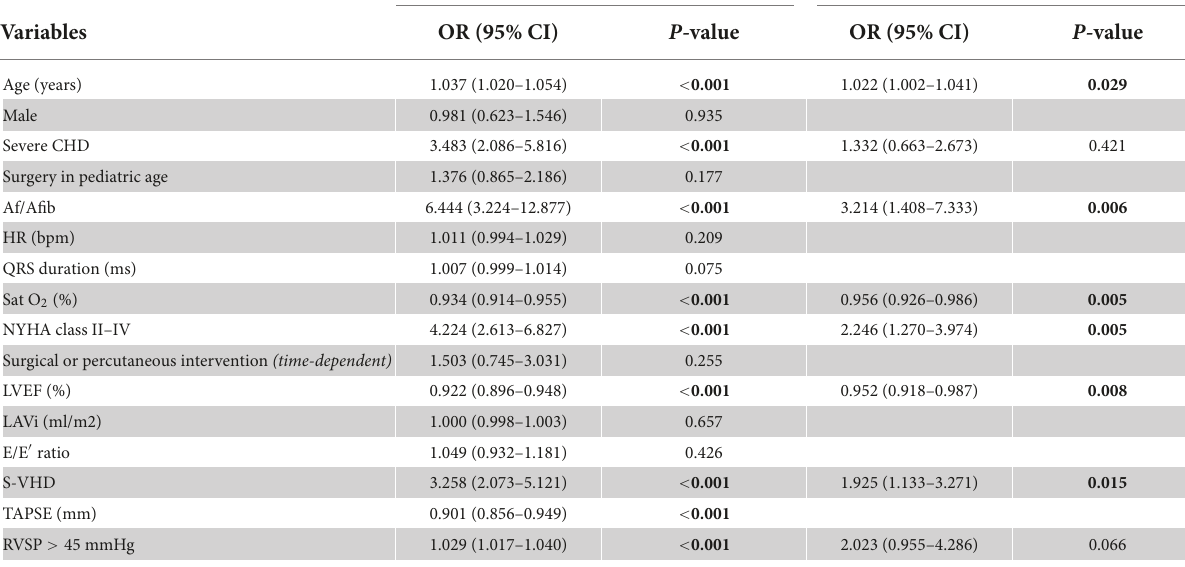
TABLE 3 Univariable and multivariable Cox regression analysis. Univariable analysis Multivariable analysis